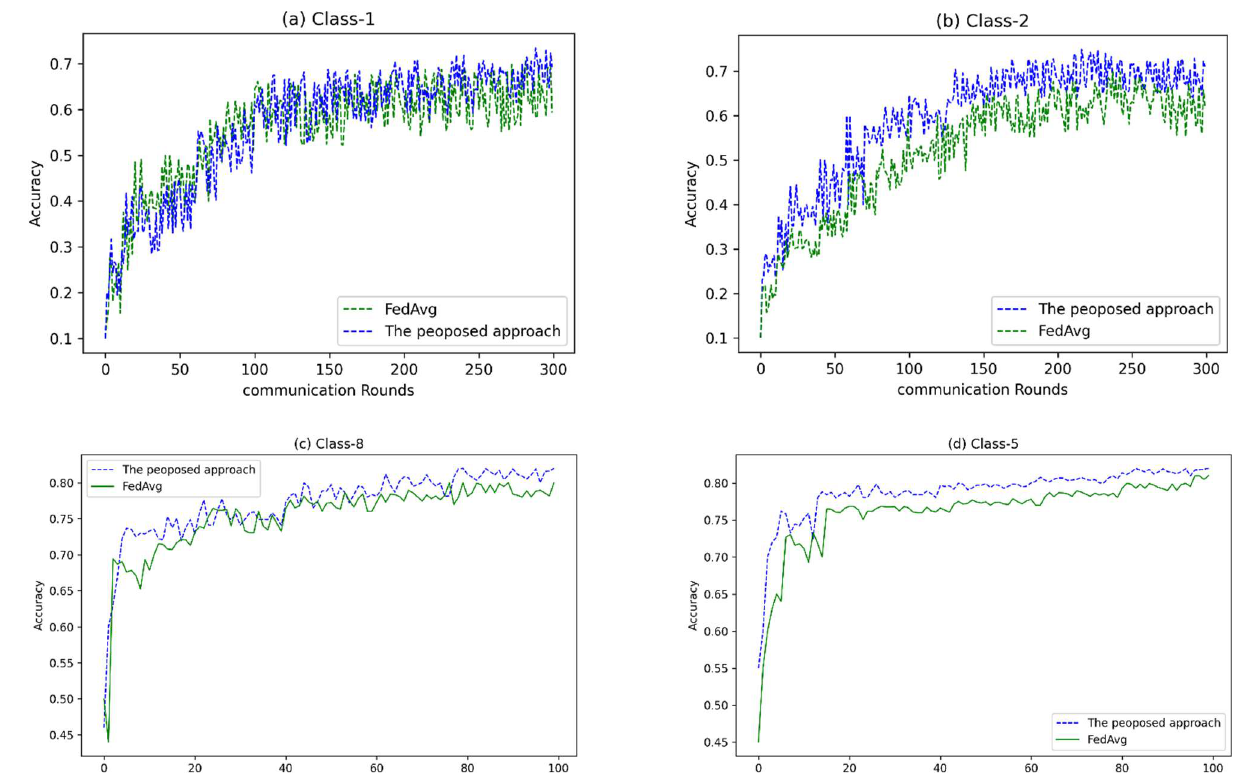
Figure 5. Accuracy for different number of communication rounds on various CIFAR-10 non-IID levels (VGG-5 DNN).